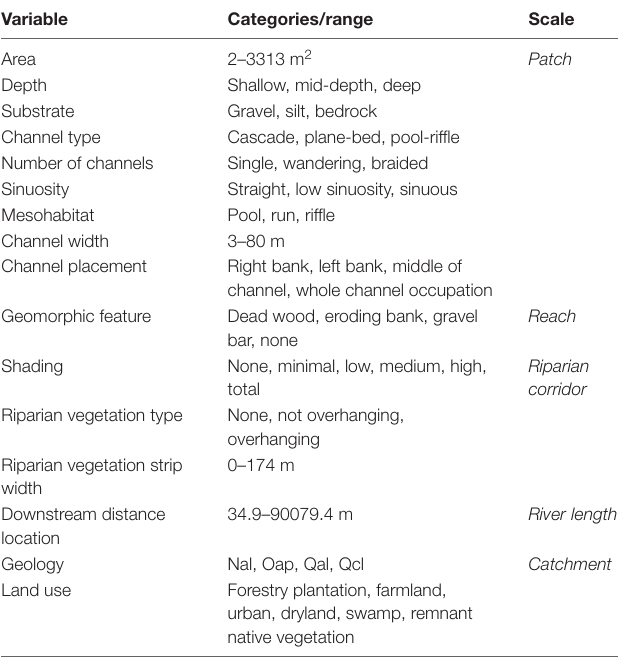
TABLE 1 | Multi-spatial physical controls of cold-water patches